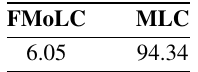
Figure 4. Multitemporal intensity SAR images acquired by ALOS/PALSAR over the Campos Basin in the Brazilian coast with HH polarization, single look, size 400x400. (a) The first acquisition in 05/22/2010 and (b) the second in 08/22/2010. Table 3 displays the overall computational time to estimate the roughness and scale parameters for each pixel of a real SAR image of size 400x400, as displayed in Fig.4, using both es- timation methods. Our approach performed significantly faster than MoLC and hence it is capable of providing reliable inputs (e.g. estimated parameters) for SAR image segmentation, clas- sification and change detection